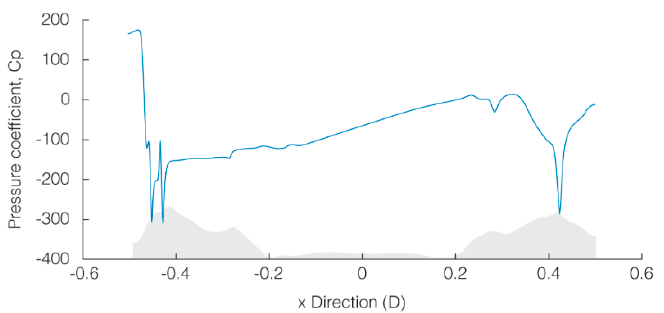
Figure 14. Pressure coefficient as a function of x.